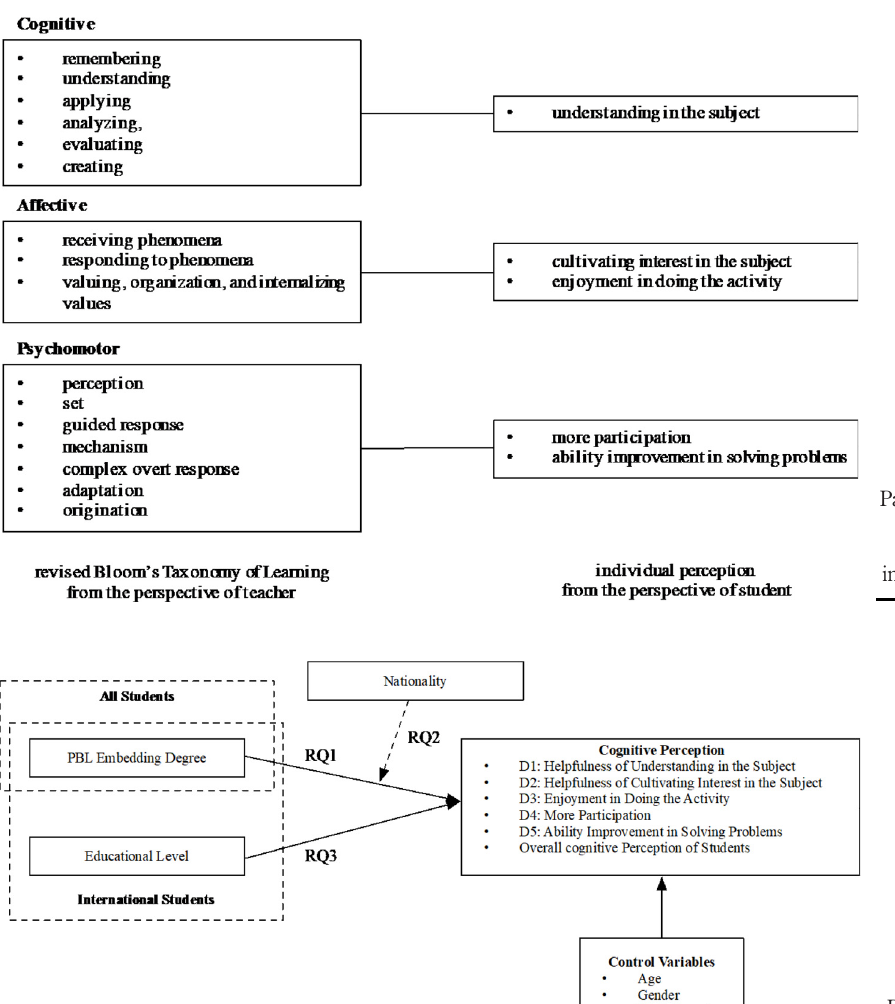
Figure 2. Research framework